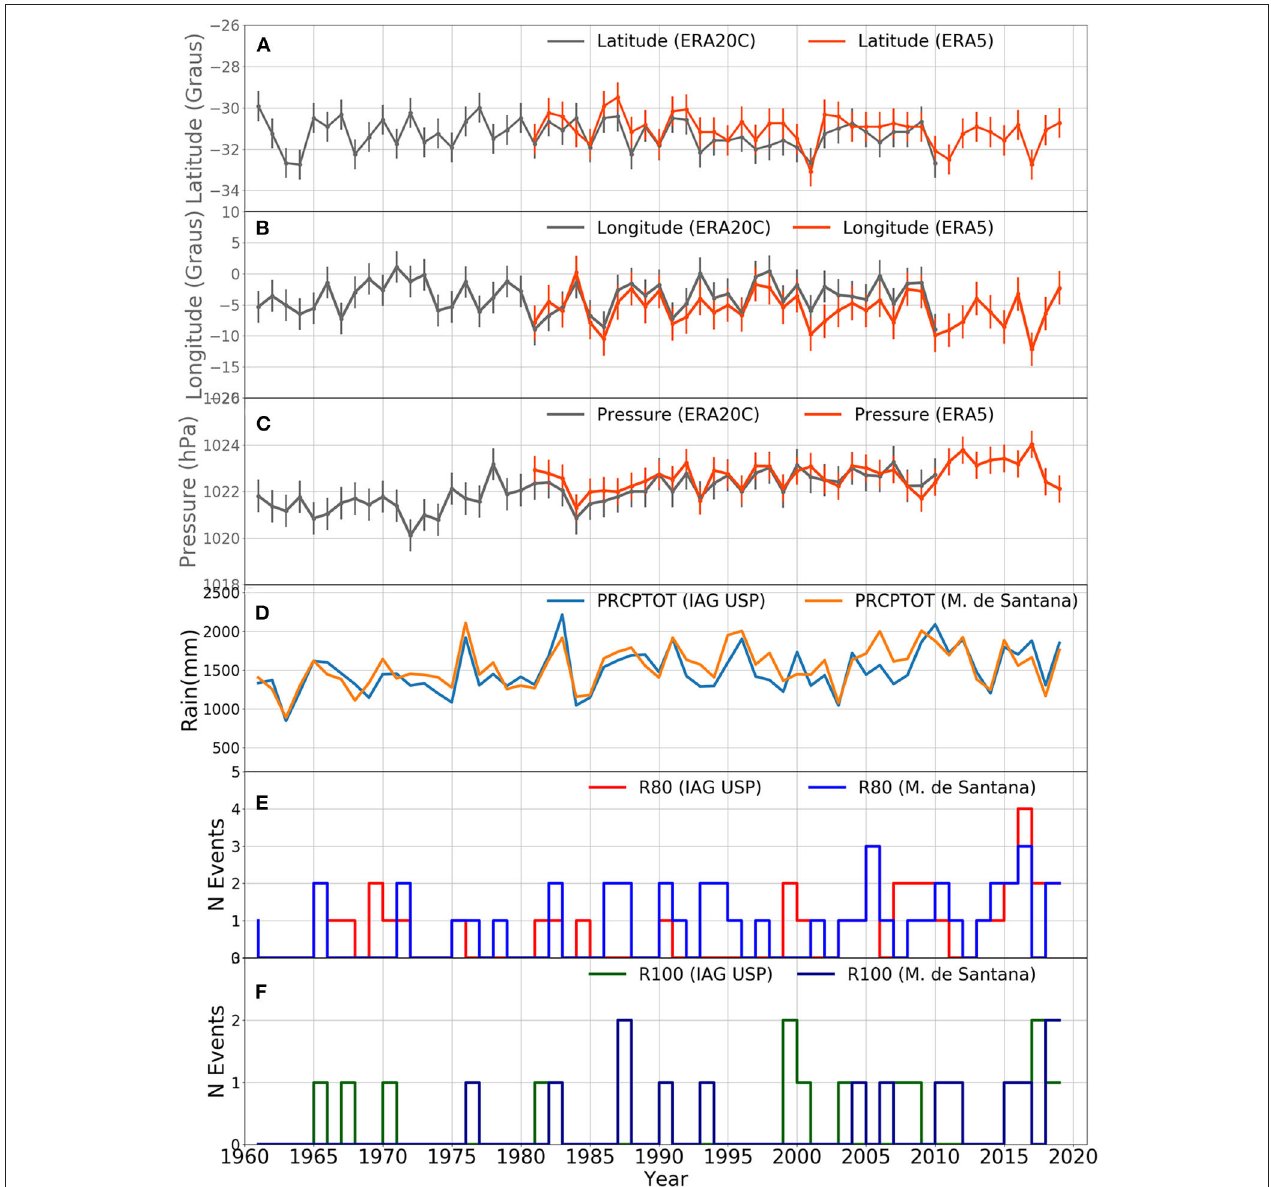
FIGURE 6 | SASA indicators: (A) Latitude, (B) Longitude, (C) Sea level pressure; (D) Annual precipitation PRPCTOT, (E) R80, and (F) R100. Vertical dashes represent the total standard deviation of the SASA series (A–C) .